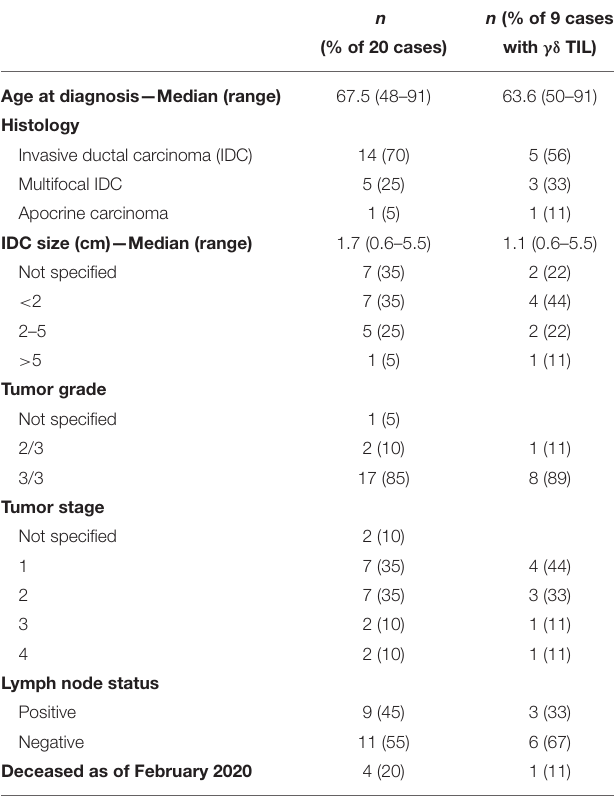
TABLE 1 | Characteristics of triple negative breast cancer cohort.